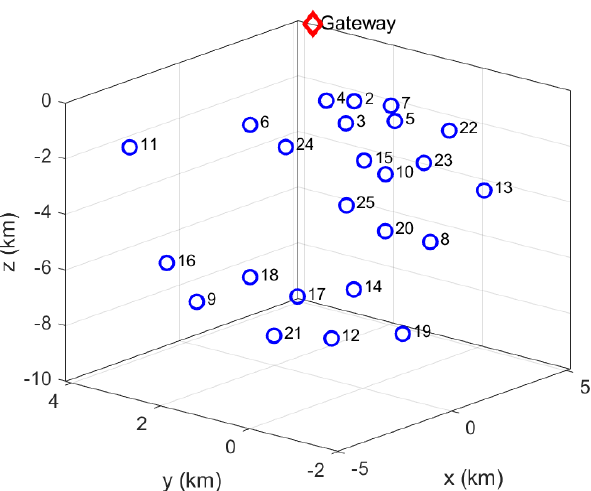
Figure 1. Random node deployment in 3D UWSNs. Data: 25 nodes (including gateway on surface), deployment zone: 10 × 6 × 10 km, minimum separation between nodes: 1 km. deployment zone: 10 × 6 × 10 km, minimum separation between nodes: 1